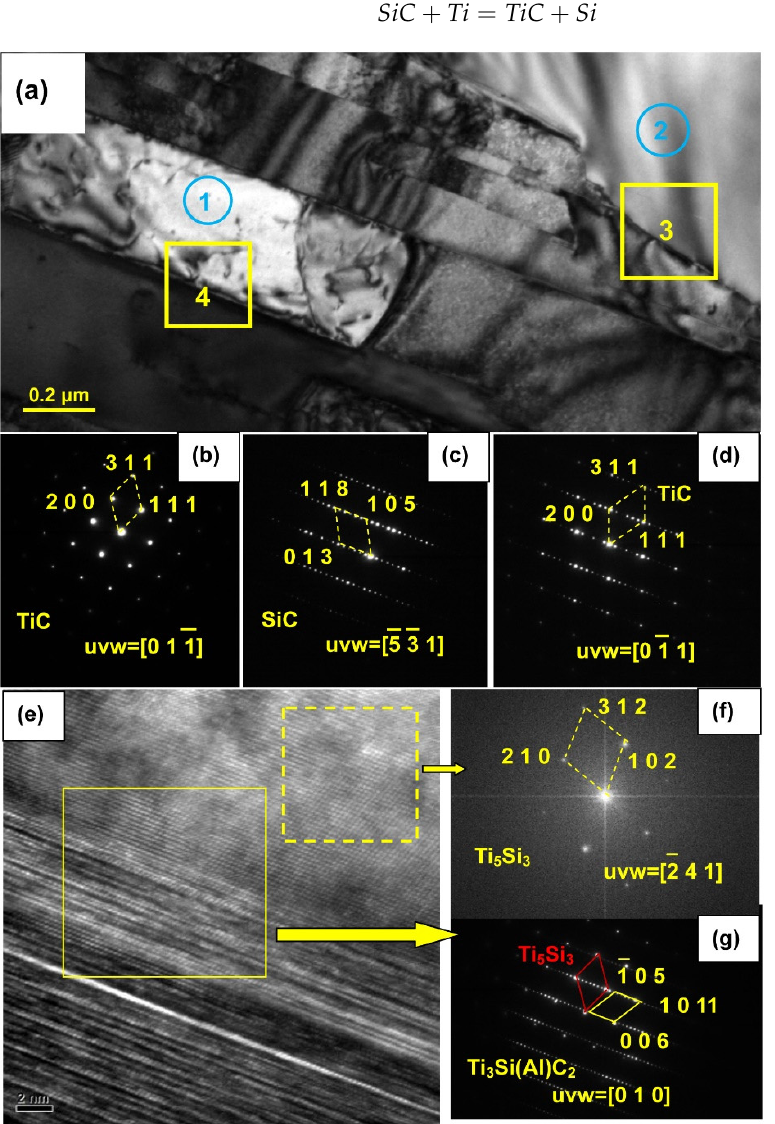
Figure 13. HRTEM images ( a ) and SAED patterns of the SiC sample infiltrated with Al alloy at 1000 °C for 6 h, ( b – d ) SAED patterns of area 1–3, ( e – g ) HRTEM and SAED of area